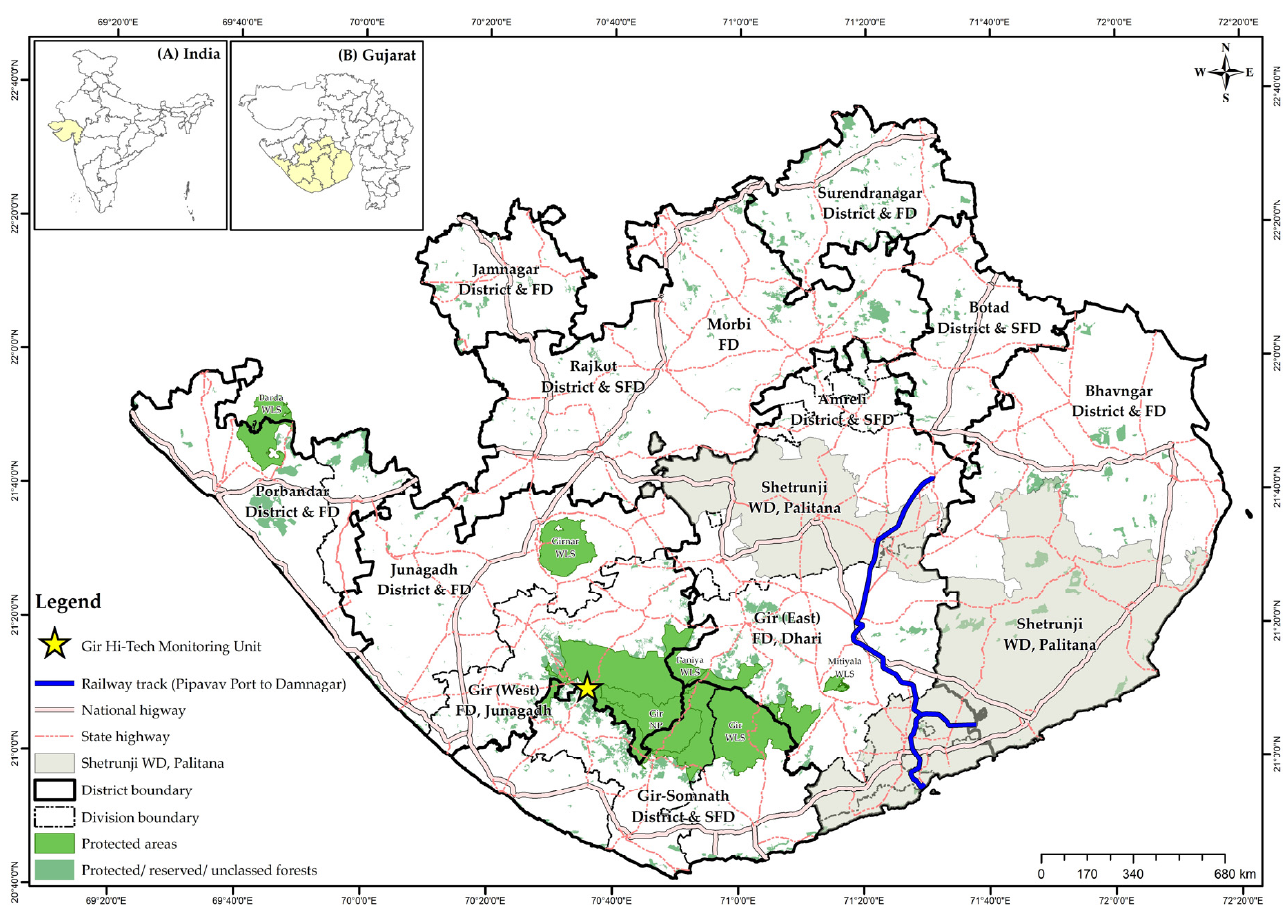
Figure 1. Asiatic Lion Landscape, Gujarat, India, with details of district boundaries, forest administrative boundaries, the Gir-Hi-Tech Monitoring Unit, Sasan-Gir, National and State Highways and Pipavav-Damnagar railway track. Insets in the map show Gujarat in India ( A ) and Asiatic Lion Landscape in Gujarat ( B ).